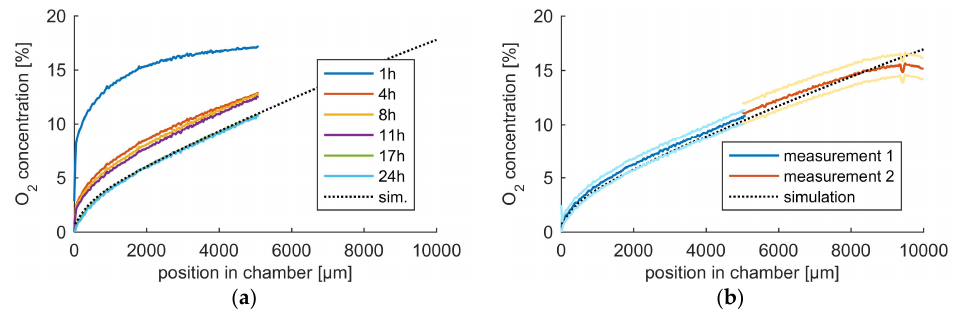
Figure 2. Measured oxygen gradient inside the microfluidic chip: ( a ) The measured oxygen concentration in the chamber at several time points compared to the simulation data and ( b ) the average oxygen concentration across the entire chamber, based on 10 measurements done within 1 h, performed in two parts. The brighter lines indicate the standard deviation of these measurements.